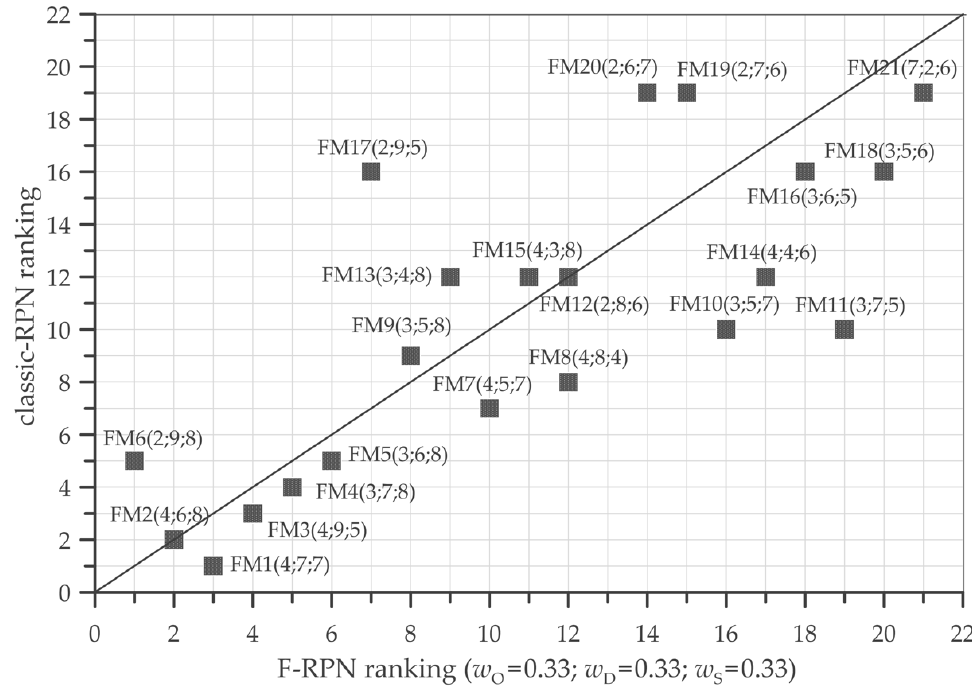
Figure 3. Comparison of rankings classic-RPN vs. Fuzzy-RPN obtained using weights of Equation (3).